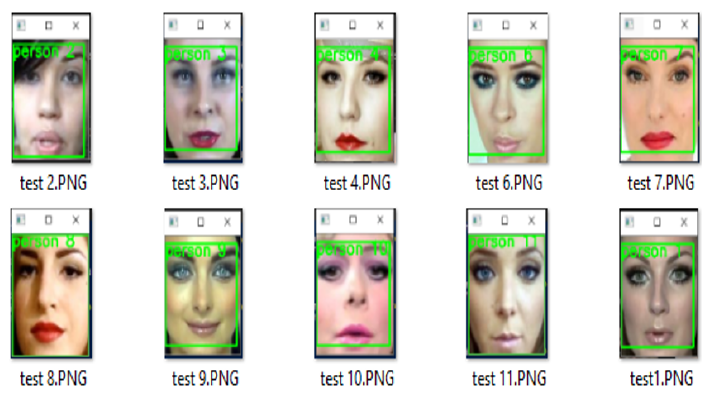
Figure 14. Output of CNN model. Table 5. Comparison of VMU with the state-of-the-art research.